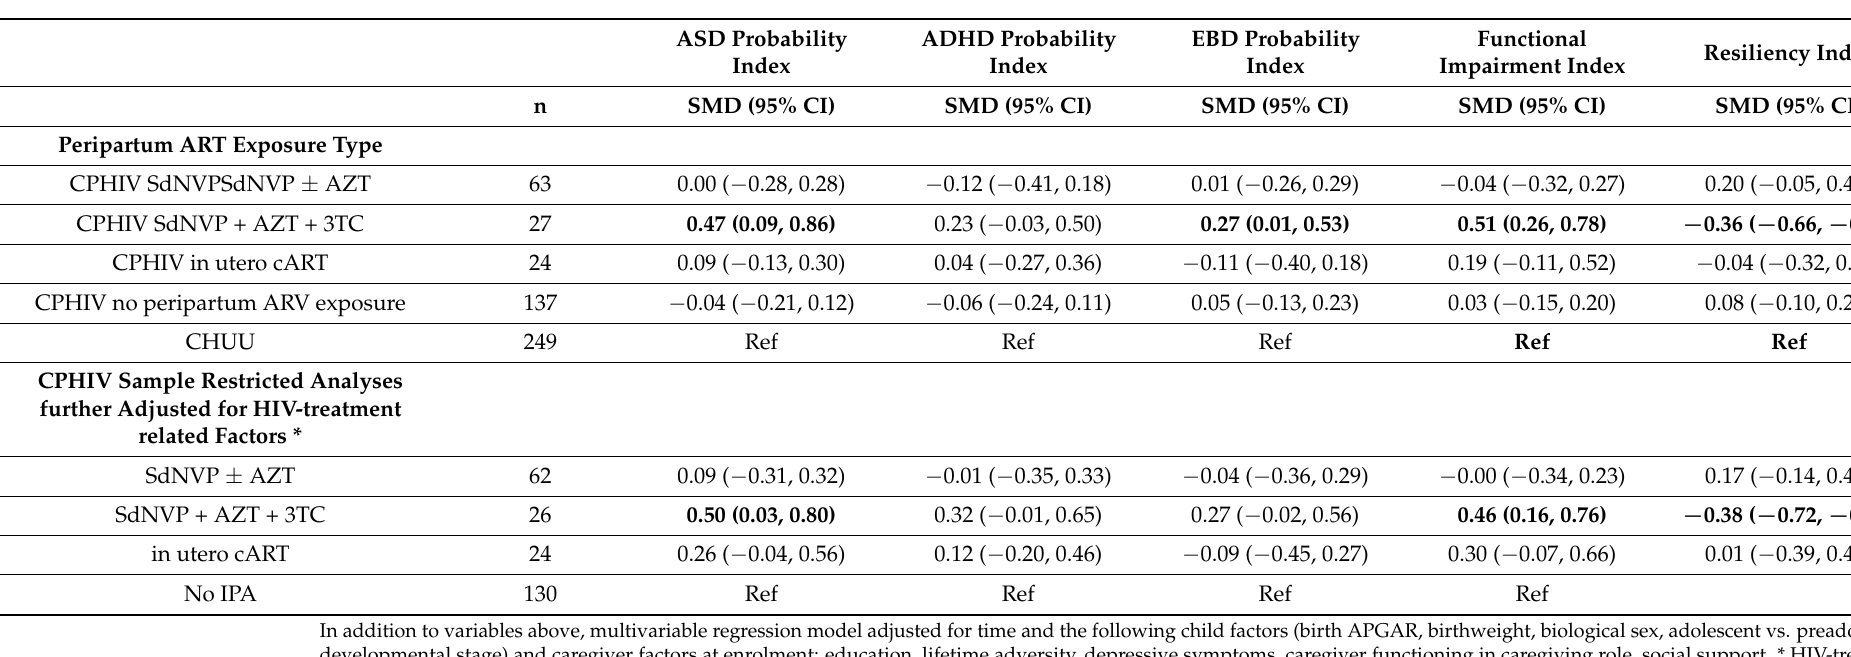
Table 4. Early-life ART exposure in relationship to ADHD probability, EBD probability, and overall resiliency at 6–18 years old for children with perinatally acquired HIV infection relative to ARV unexposed peers and children HIV unexposed uninfected from